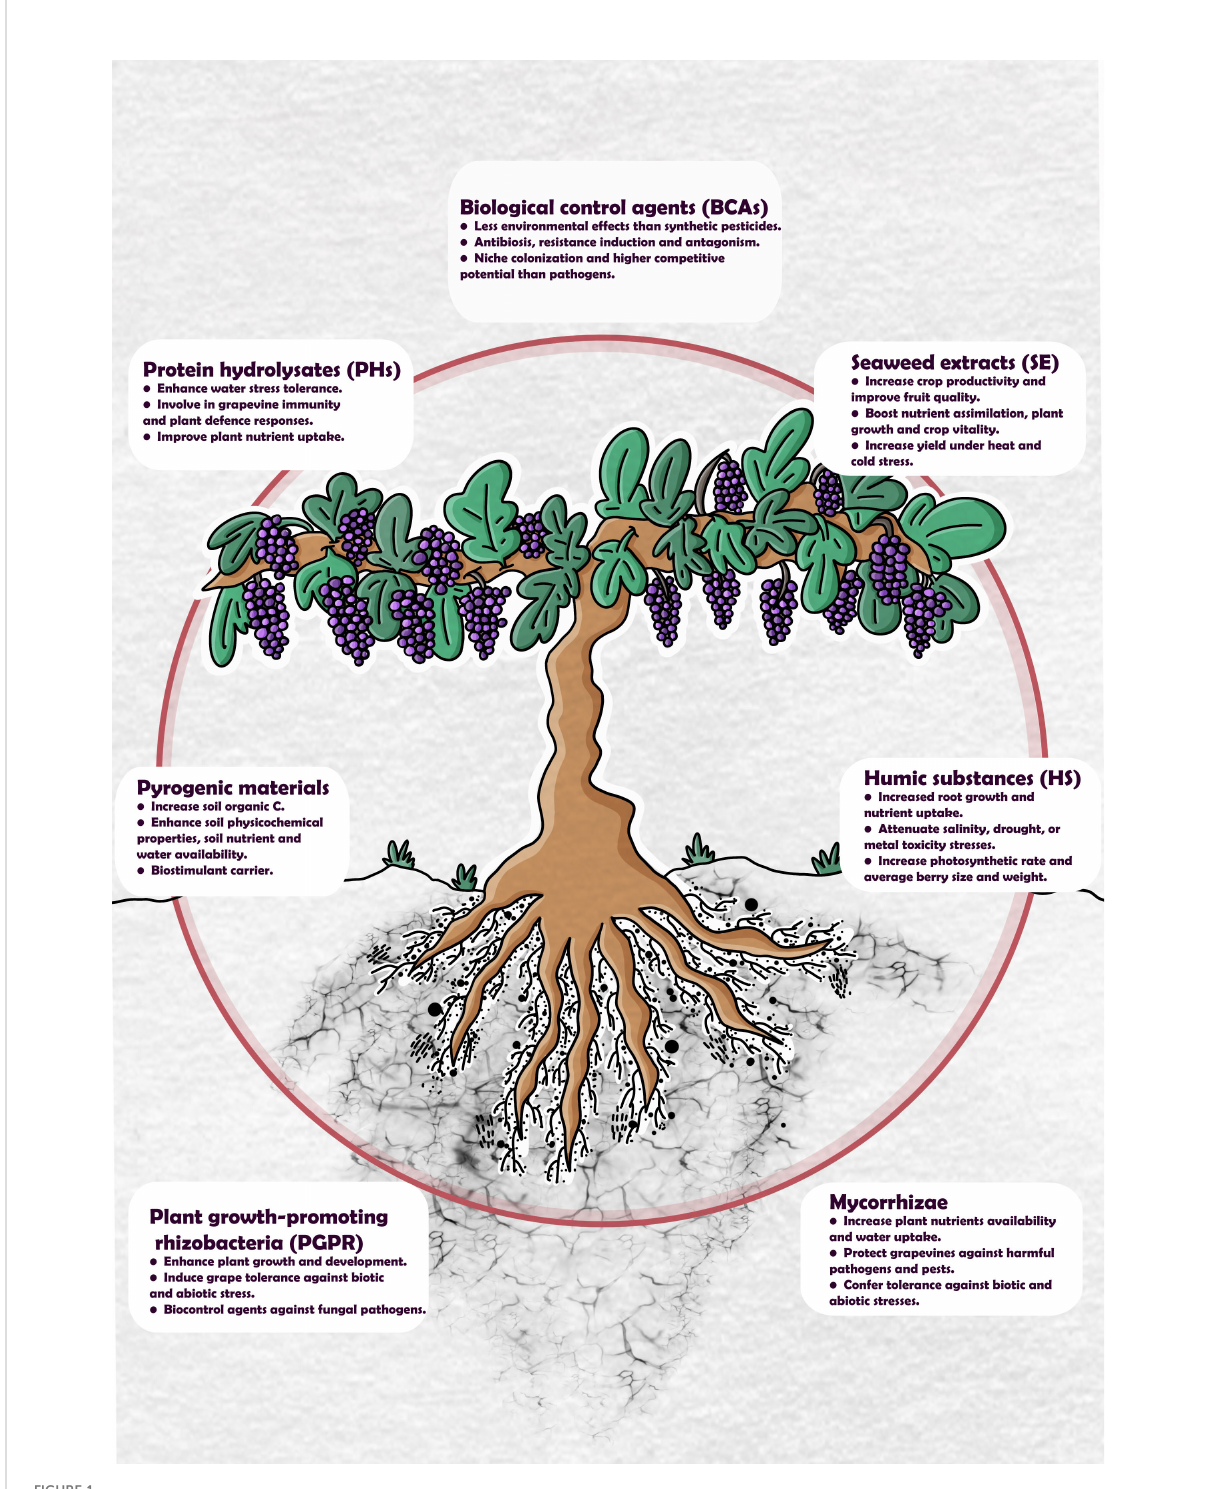
FIGURE 1 An overview of the main effects of biological control agents (BCAs), protein hydrolysates (PHs), seaweed extracts (SE), pyrogenic materials, humic substances (HS), plant growth-promoting rhizobacteria (PGPR), and mycorrhizae applied in